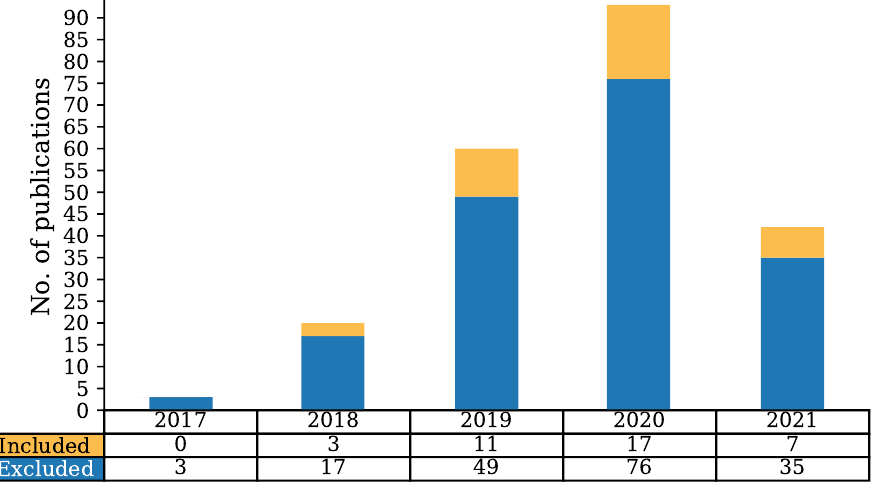
Figure 2. Number of papers included and excluded in our